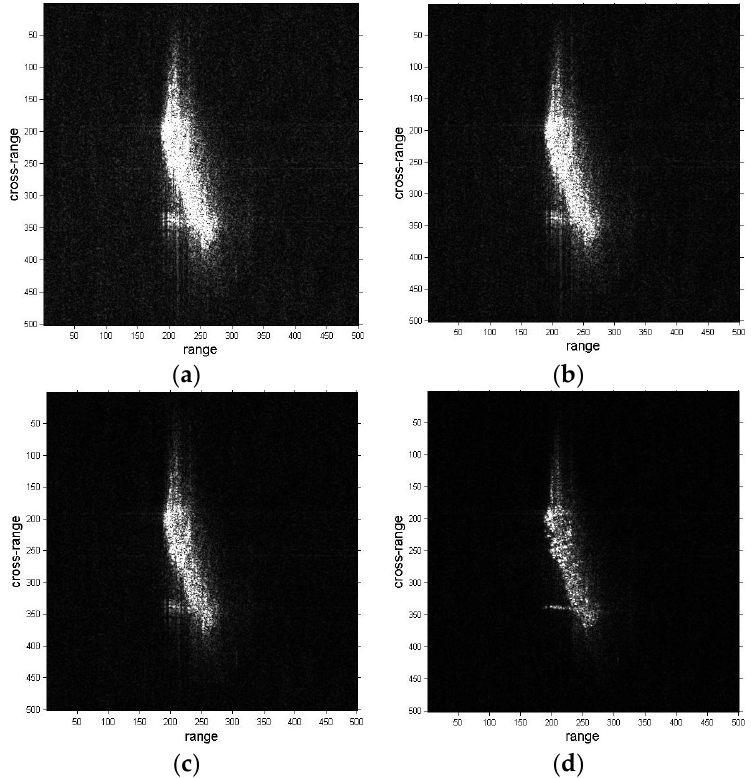
Figure 11. Refocused images of ship03 sub-image. ( a ) Sub-image of ship03; ( b ) Refocused image with DCT method; ( c ) Refocused image with PGA method; ( d ) Refocused image with proposed method.